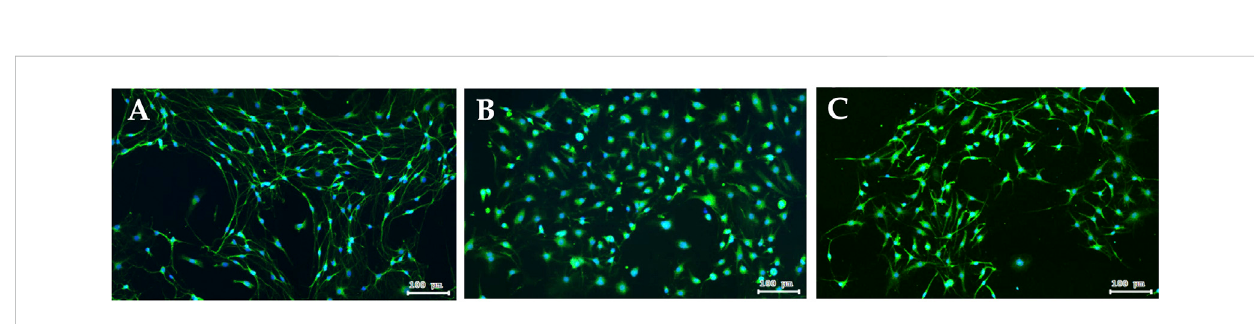
FIGURE 8 Fluorescence images of peripherin staining in DRG neuron. DRG neuron (A) ; Paclitaxel induced nerve fi bers shortening of DRG neuron for 24 h (B) ; after 24 h co-culturing with XSLJZT, the medium was changed, and then co-cultured with 0.05 μ M paclitaxel for another 24 h (C)